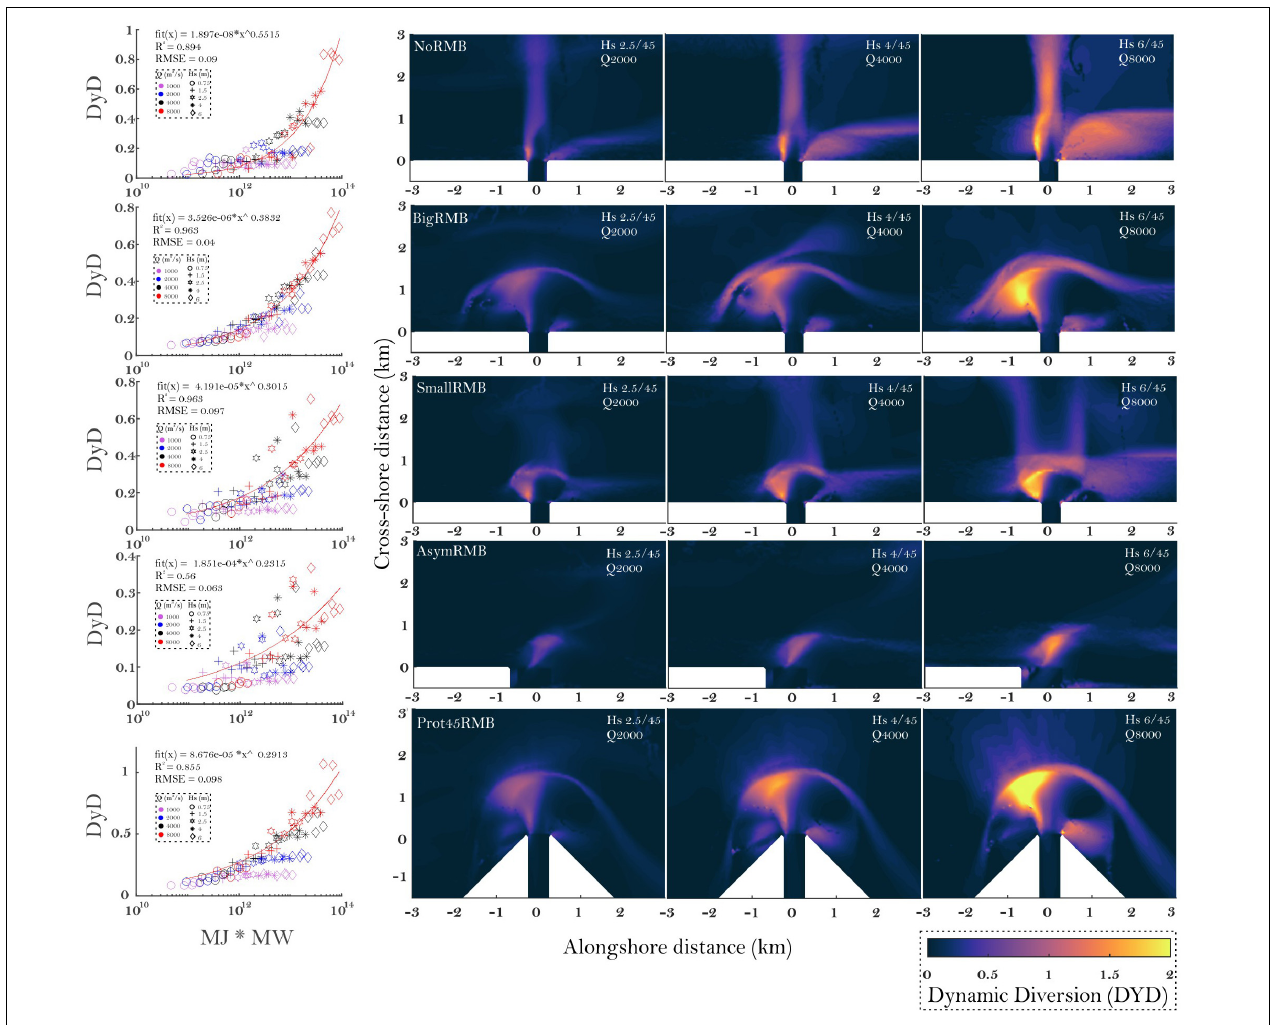
FIGURE 13 | A selection of the Combined Dynamic diversion index ( DyD ) for the five types of RMB with both increasing Hs and discharge ( Q ). Scatter plots on the left show the relation of the average DyD with all the numerical simulations for each RMB